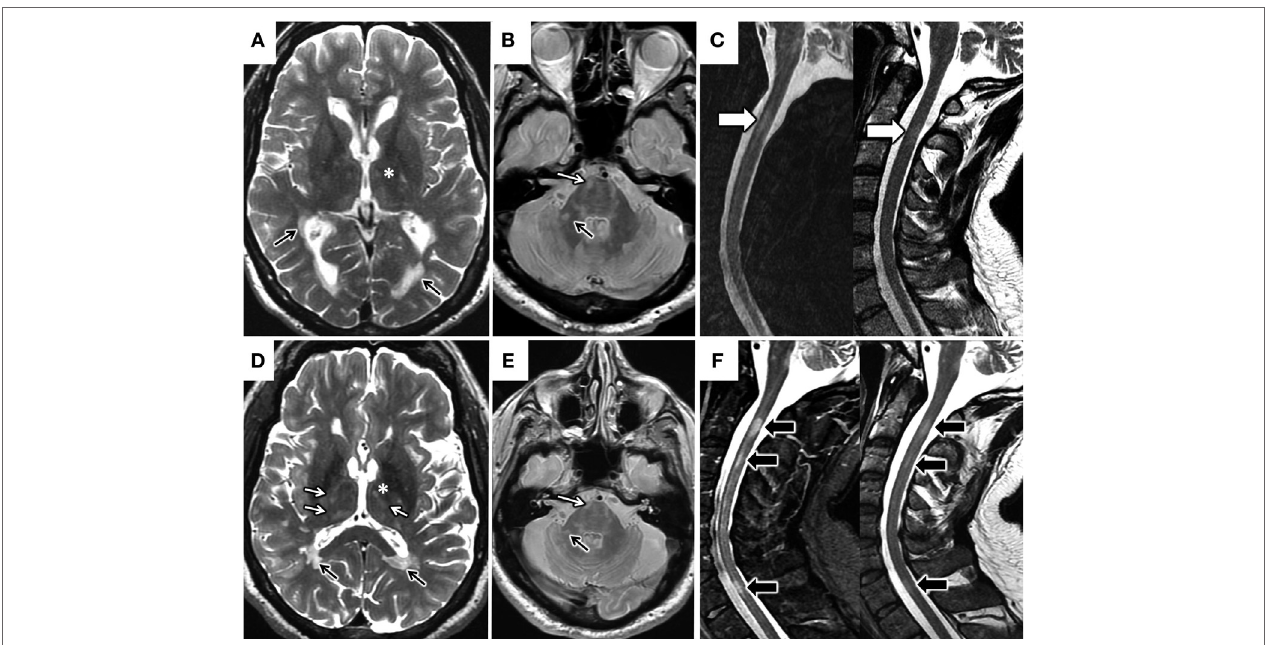
FIGURe 1 | Changes in brain and spinal cord MRI. MRI 2010 (a–C) . Axial T2 FSE MRI image of the brain (a) demonstrates multiple periventricular lesions in the lateral ventricles (black arrows) and scarce thalamic lesions (*). Axial proton-density-weighted MRI image (B) shows predominant infratentorial lesions (white arrow in pons and black arrow in right middle cerebellar peduncle). Sagittal STIR and T2 FSE MRI images of the spinal cord (C) highlight the presence of a short segment spinal cord lesion (white arrow in C2). MRI 2016 (D–F) . Axial T2 FSE MRI image (D) shows increased in the number of thalamic lesions (* and white arrows) and stability of the periventricular lesions (black arrows). Axial proton-density-weighted MRI image (e) shows stability of the infratentorial lesions respect to 2010 (arrows). Sagittal STIR and T2 FSE MRI images of cervical spinal cord (F) demonstrate new short segment lesions affecting C3 and C7 levels respect (black arrows).